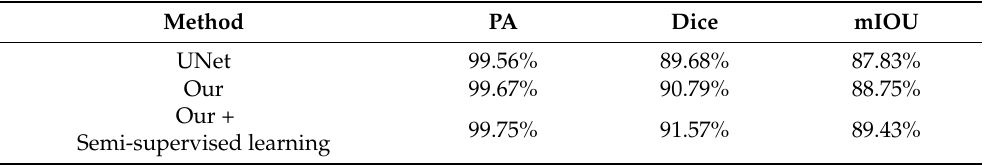
Table 4. Semi-supervised learning effectiveness comparison table.